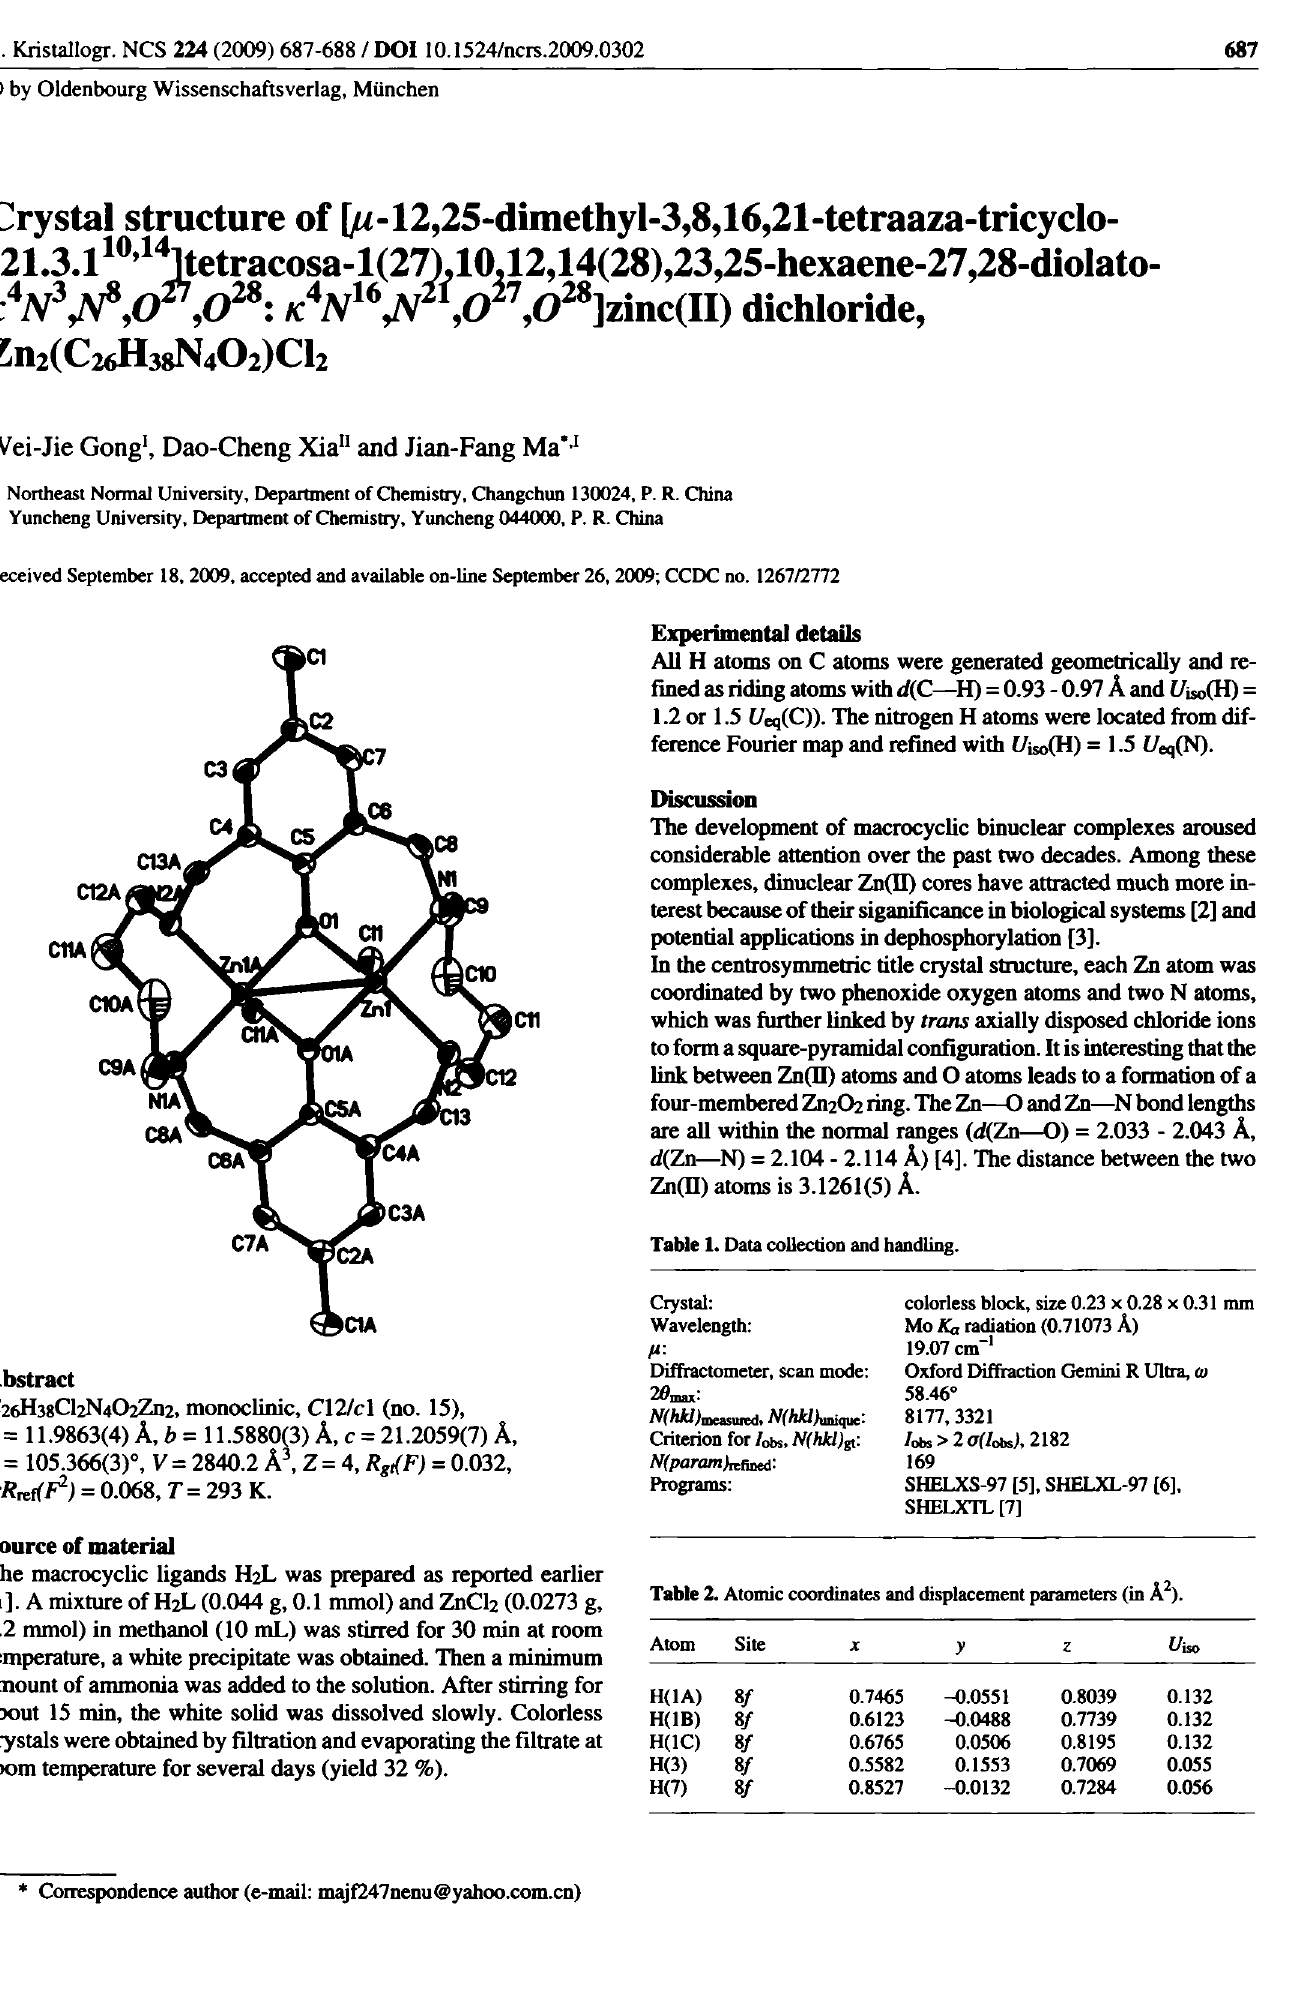
Table 2. Atomic coordinates and displacement parameters (in Â 2